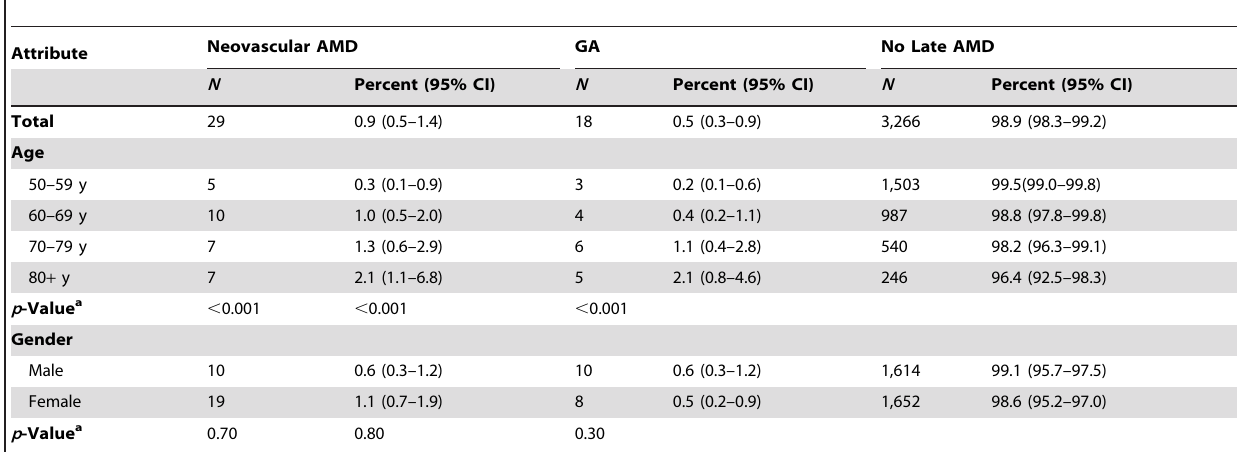
Table 3. Number and prevalence of features of late AMD (image group) by sex and age ( n =3,304).